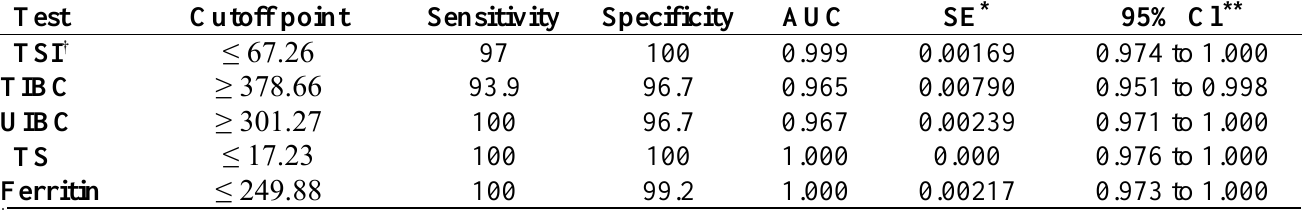
Table 2. Estimation of cutoff point test between sensitivity and specificity for iron status parameters that use the main test for diagnosis trypanosomiasis in Iraqi